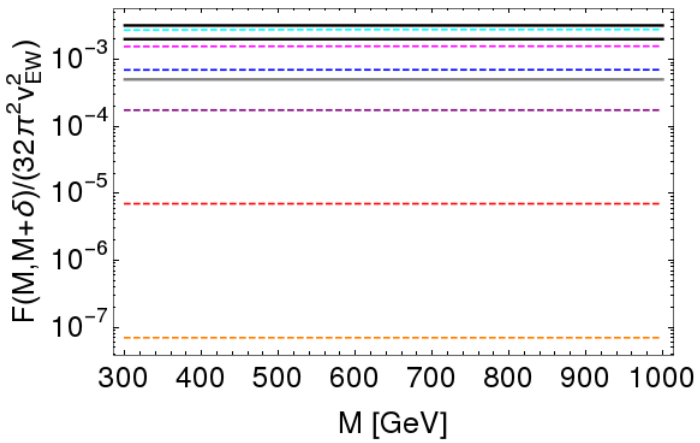
), where (cid:14) = EW